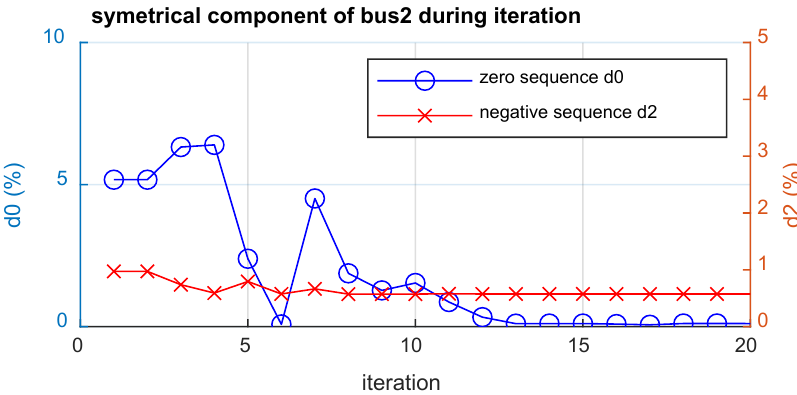
Figure 7. Minimum fitness functions during iterations in Case B.